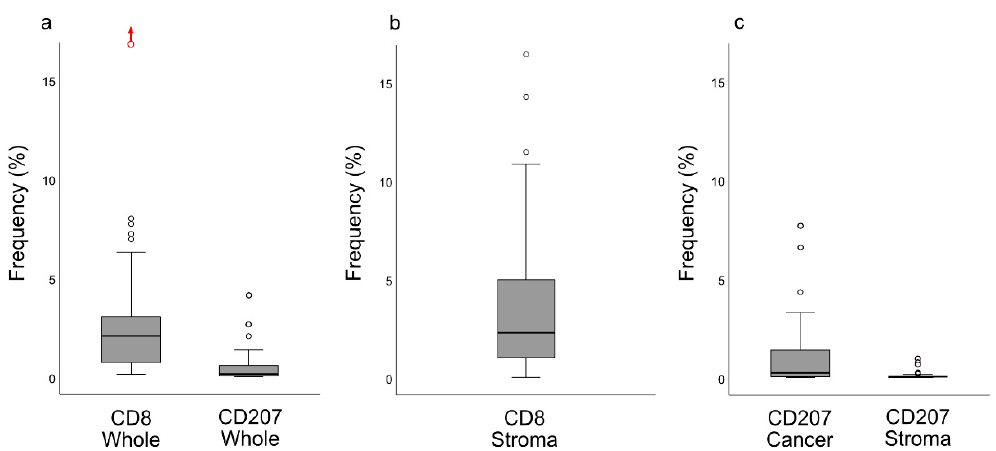
Figure 4. CD8 and CD207 frequency (%) presented as boxplots (median and IQR with whiskers denoting 1.5 IQR and outliers as circles) for the whole biopsies ( a ) as well as for selected areas: ( b ) CD8 and ( c ) CD207. There was a difference between CD207 ratios between areas of cancer cells and the surrounding stroma ( p < 0.0001). In ( a ), an extreme outlier (frequency: 24%), deemed an accurate observation, is indicated with a red circle and an upwards pointing red arrow. Abbreviation: IQR = interquartile range.